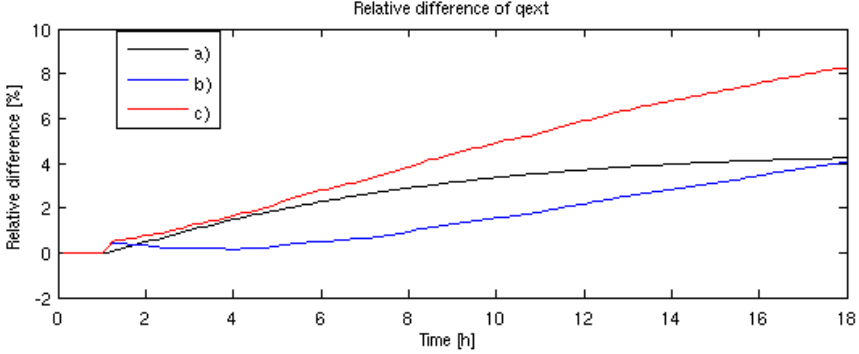
Fig. 8. The relative difference of the light extinction coefficient. In the legend (a) stands for comparison between reallocated and full moving Figure 8: The relative difference of the light extinction coefficient. In the legend models, (b) for full moving vs. sectional and (c) for reallocated vs. sectional a) stands for comparison between reallocated and full moving models, b) for full moving vs. sectional and c) for reallocated vs. sectional model.